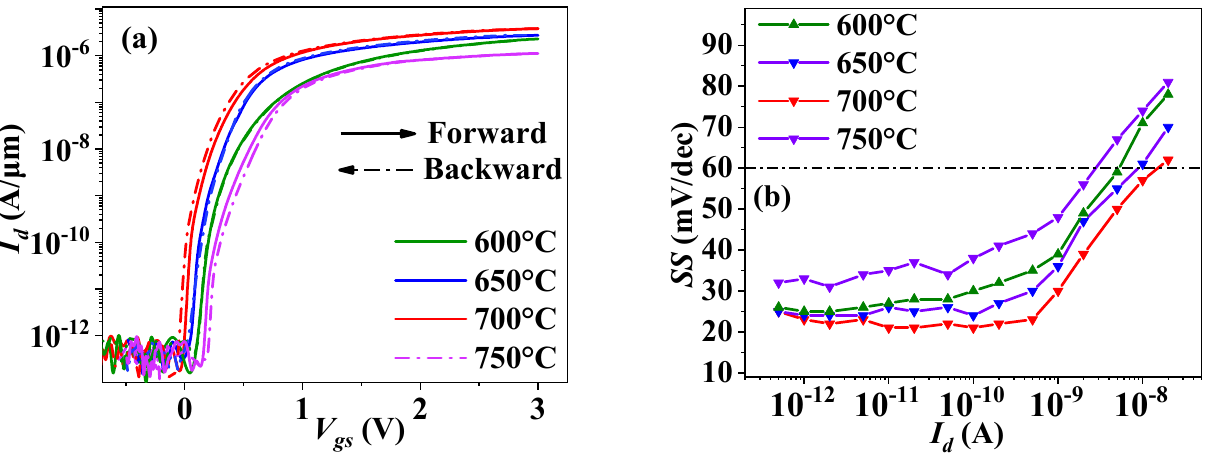
Figure 5. ( a ) Transfer curves and ( b ) SS-I d curves for the Hf 0.475 Zr 0.475 Al 0.05 O y NCFETs with different annealing temperatures (Al ratio: 5%). Table 3. Zr 0.475 Al 0.05 O y NCFETs with different annealing temperatures ( T ) extracted from their transfer